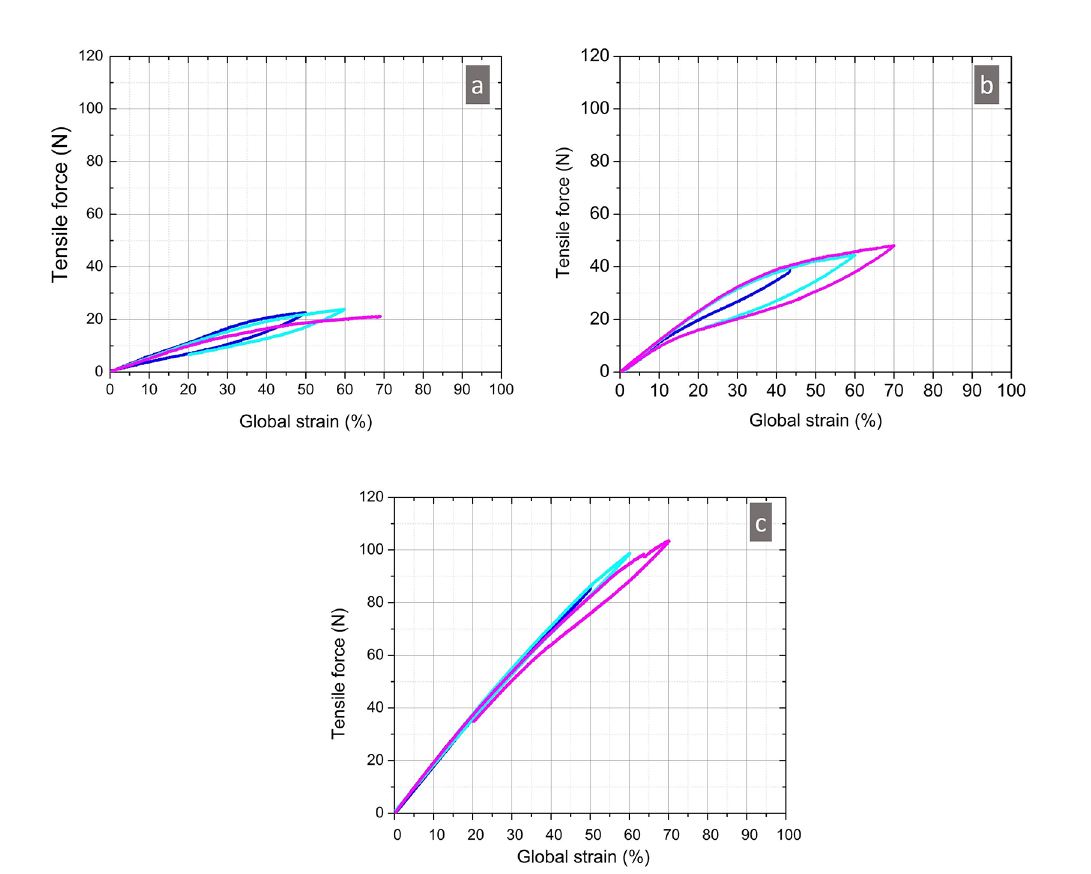
Figure 6. Force versus global strain for heat-treated Ni-Ti SMA springs. a) SPG-D1.0. b) SPG-D1.5. c)